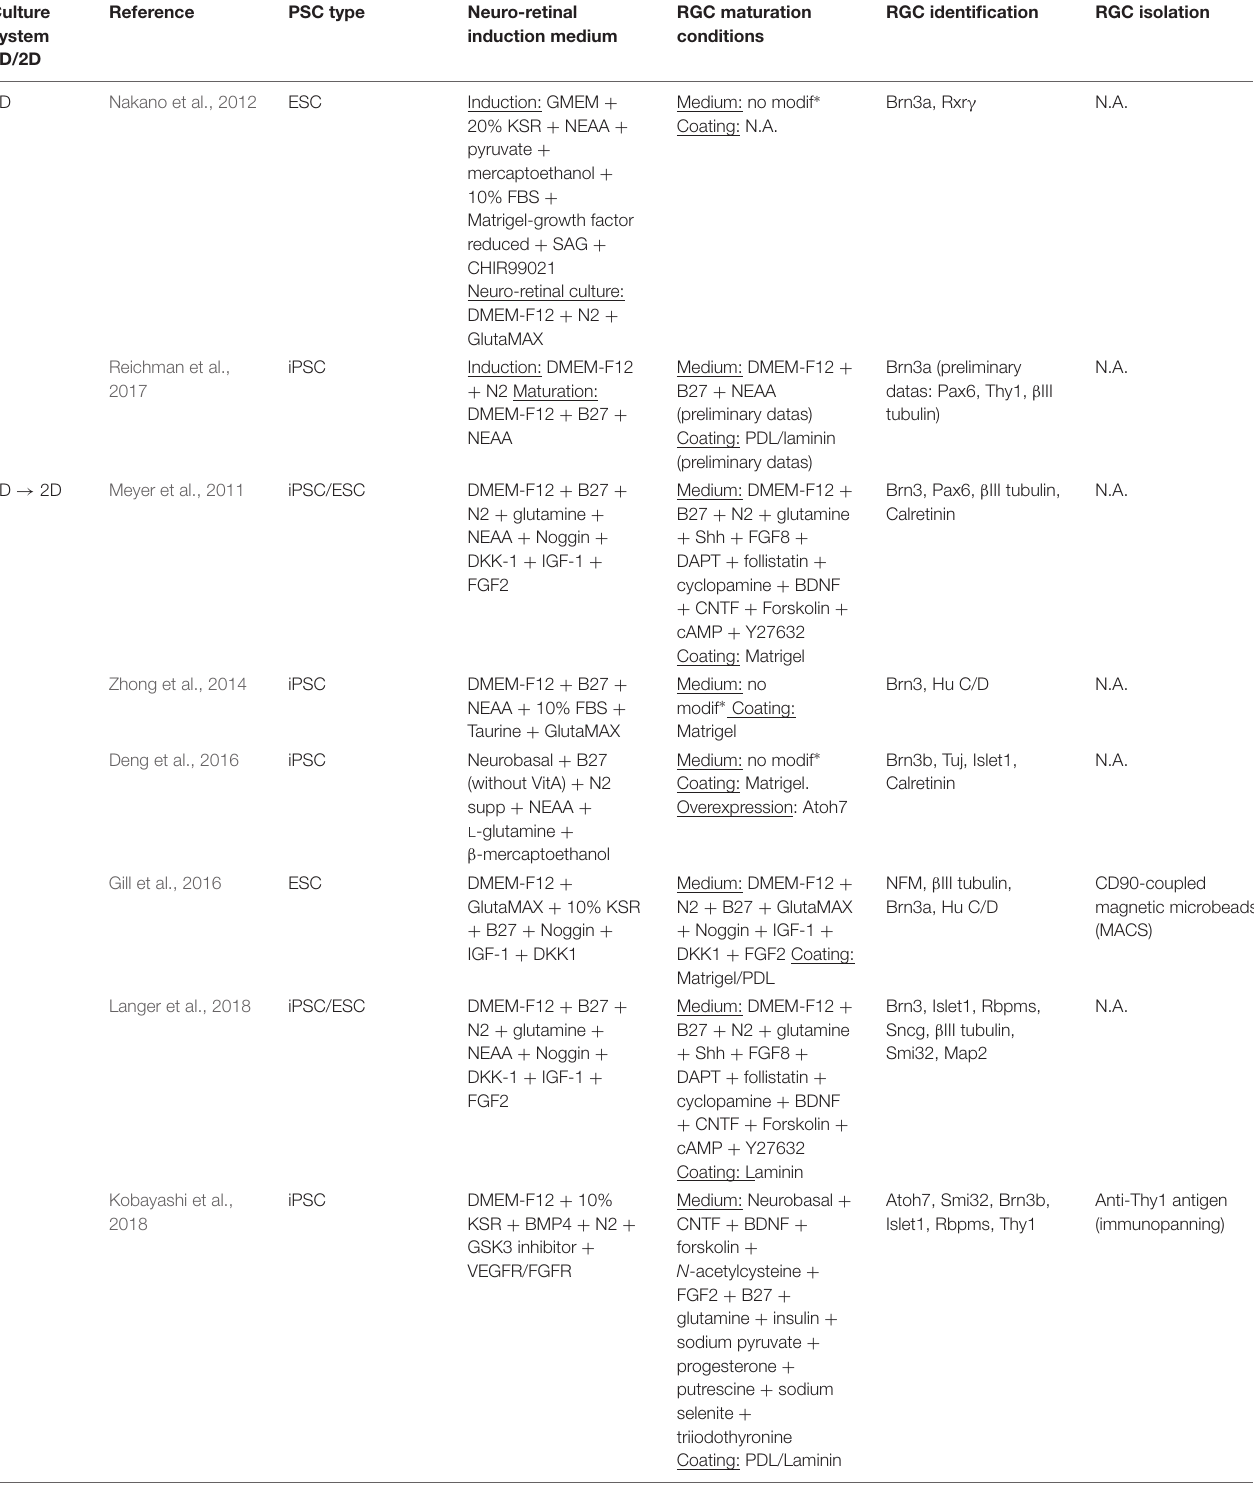
TABLE 2 | Retinal ganglion cell differentiation protocols from human